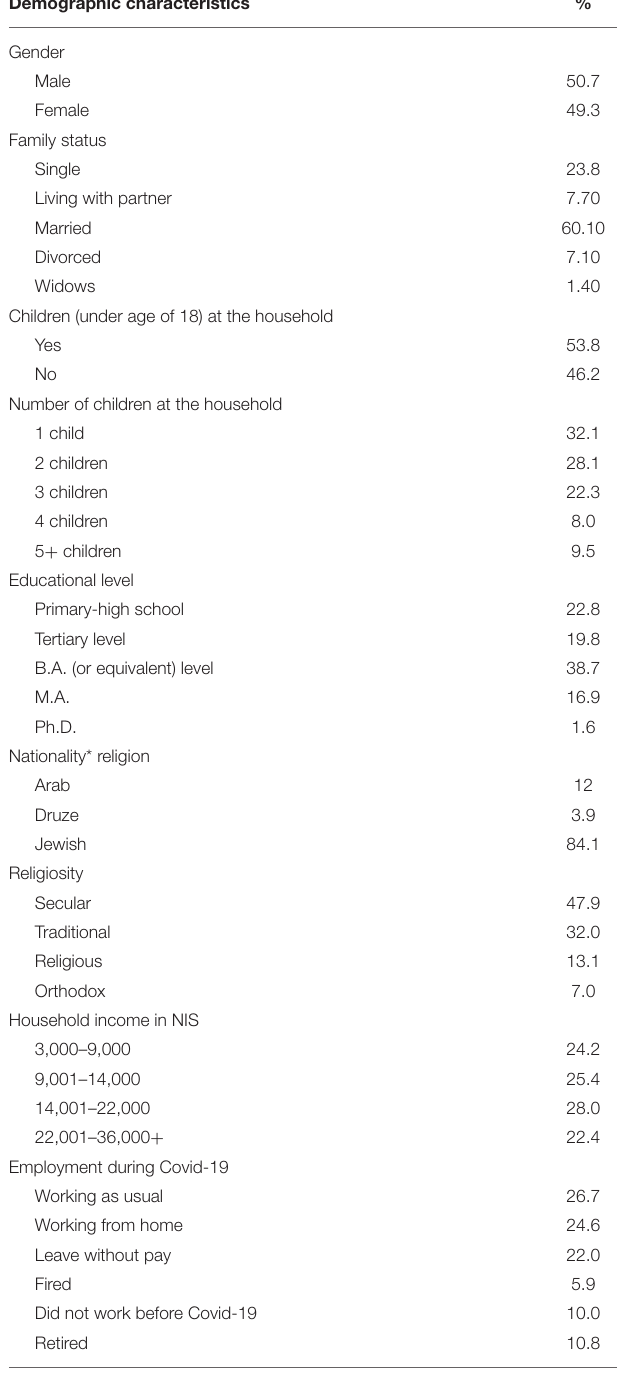
TABLE 1 | Participants demographic characteristics ( N =